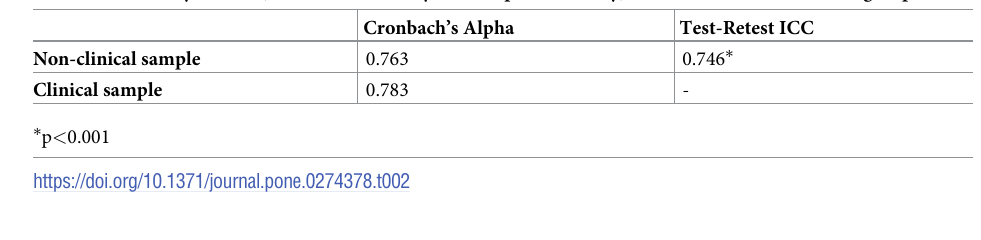
Table 2. Reliability indices (internal consistency and temporal stability) for non-clinical and clinical